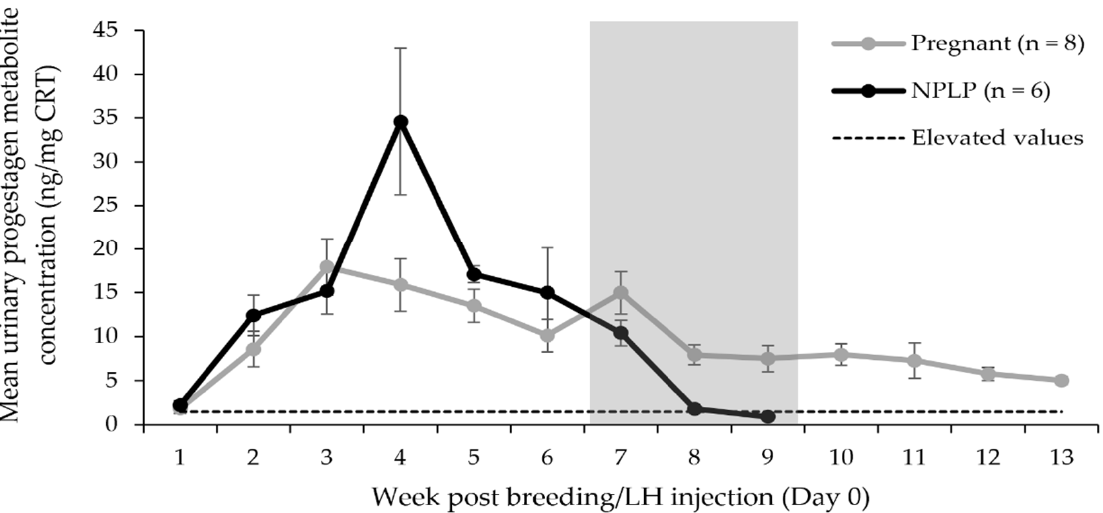
Figure 5. Weekly raw mean urinary progestagen metabolite concentrations in samples collected from female cheetahs after natural breeding or hormone administration and either giving birth to offspring (pregnant), or exhibiting fecal progestagen metabolite concentrations indicative of ovulation, but no offspring were produced (NPLP). Elevated values were determined to be all those above a value three times a non-ovulatory mean baseline urinary progestagen metabolite concentration (1.5 ng/mg CRT). The shaded area indicates the three-week term in which pregnant values were higher than NPLP concentrations ( p < 0.001).